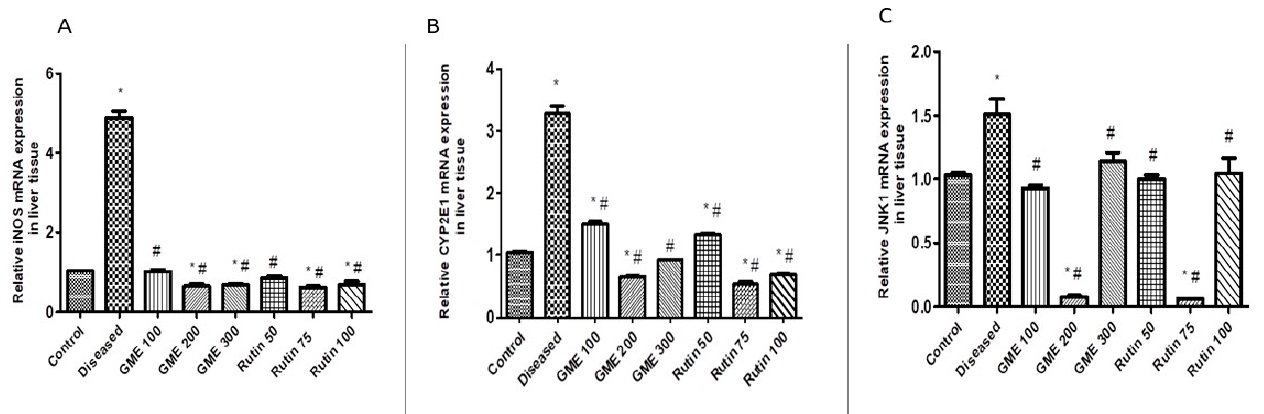
Figure 5. The impact of rutin and total methanolic extract at different doses on relative gene expression qRT–PCR as follows: ( A ); iNOS. ( B ); CYP2E. ( C ); JNK1. Data displayed as mean ± SD, n = 6 per group. Statistically, a significant difference resulted from a one-way ANOVA followed by Tukey’s multiple comparison test. Data was significant at p -value < 0.05. *: significant according to the normal control group. #: significant according to the diseased group. GME: G. thunbergia methanol extract of leaves. Control: normal control group. Diseased: diseased group.